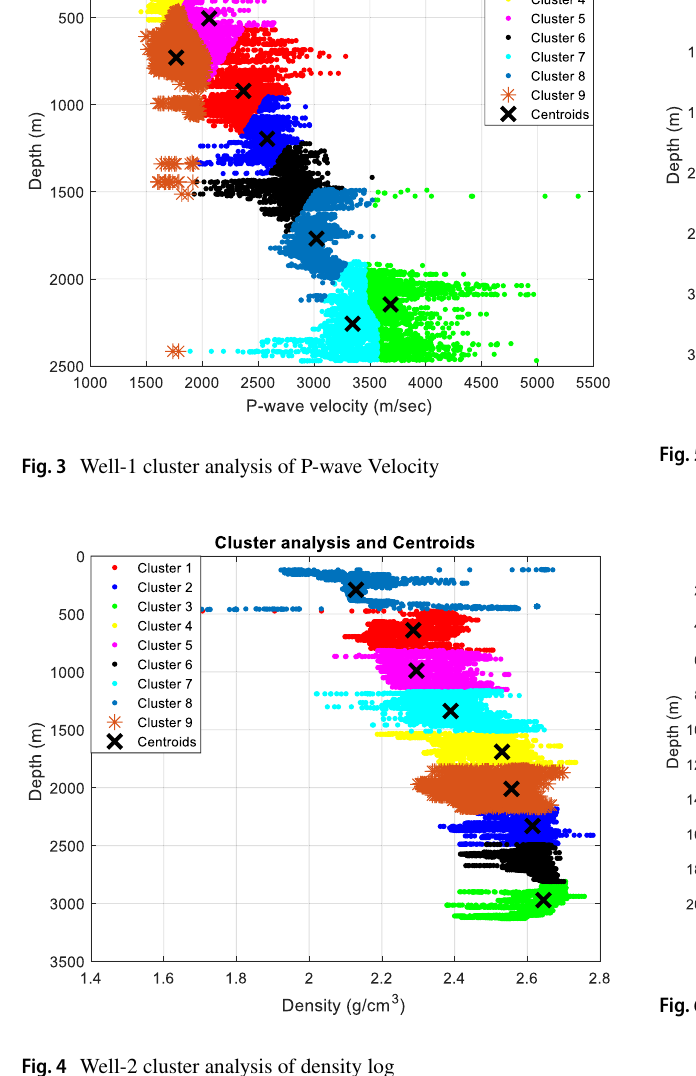
Fig. 4 Well-2 cluster analysis of density log